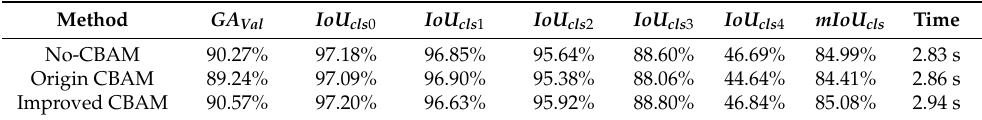
Table 5. The metrics results of Deeplabv3+–Mobilenetv2 with CBAM and without CBAM. Table 4. The metrics results of Deeplabv3+–Mobilenetv2 under different conditions.